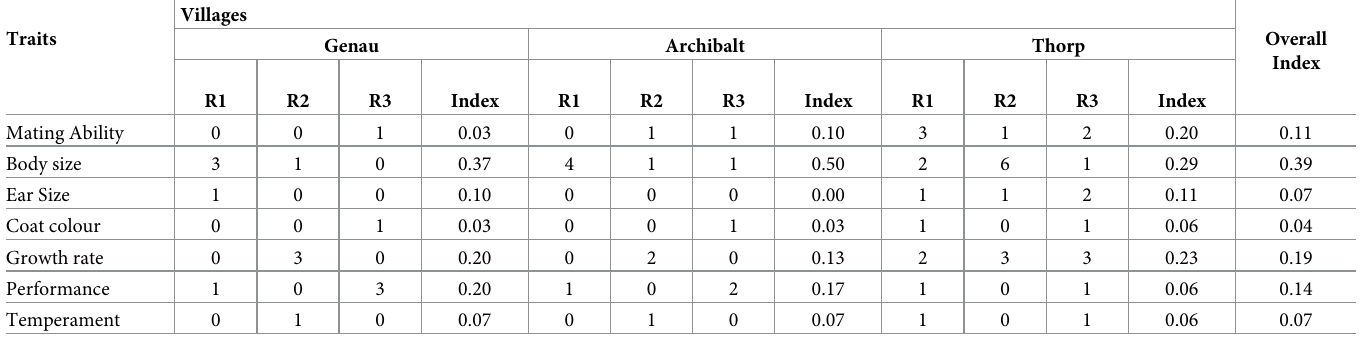
Donkey colour variations were noticed in the investigation on three separate villages, as shown in Table 6. The donkey colours in the three communities were not statistically substantially dif- ferent (P > 0.05), and the same colours existed in each hamlet. In the current study, the don- keys’ colours were mostly dark brown (Fig 3), light brown (Fig 4), white (Fig 5), grey (Fig 6), and chuck coal (Fig 7). Table 4. Ranks and indices for trait preference in male donkeys.